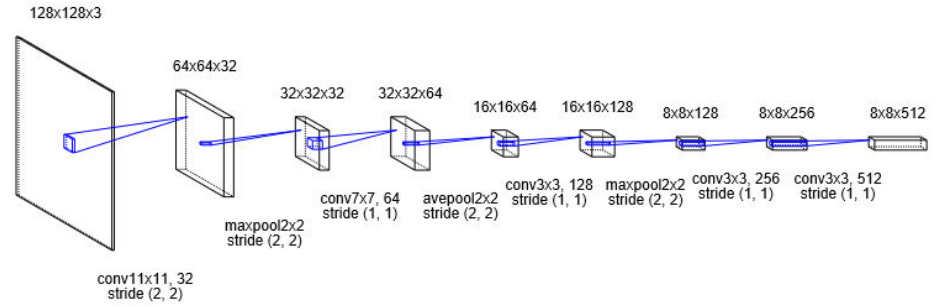
Figure 4. Basic structure of convolution neural network.